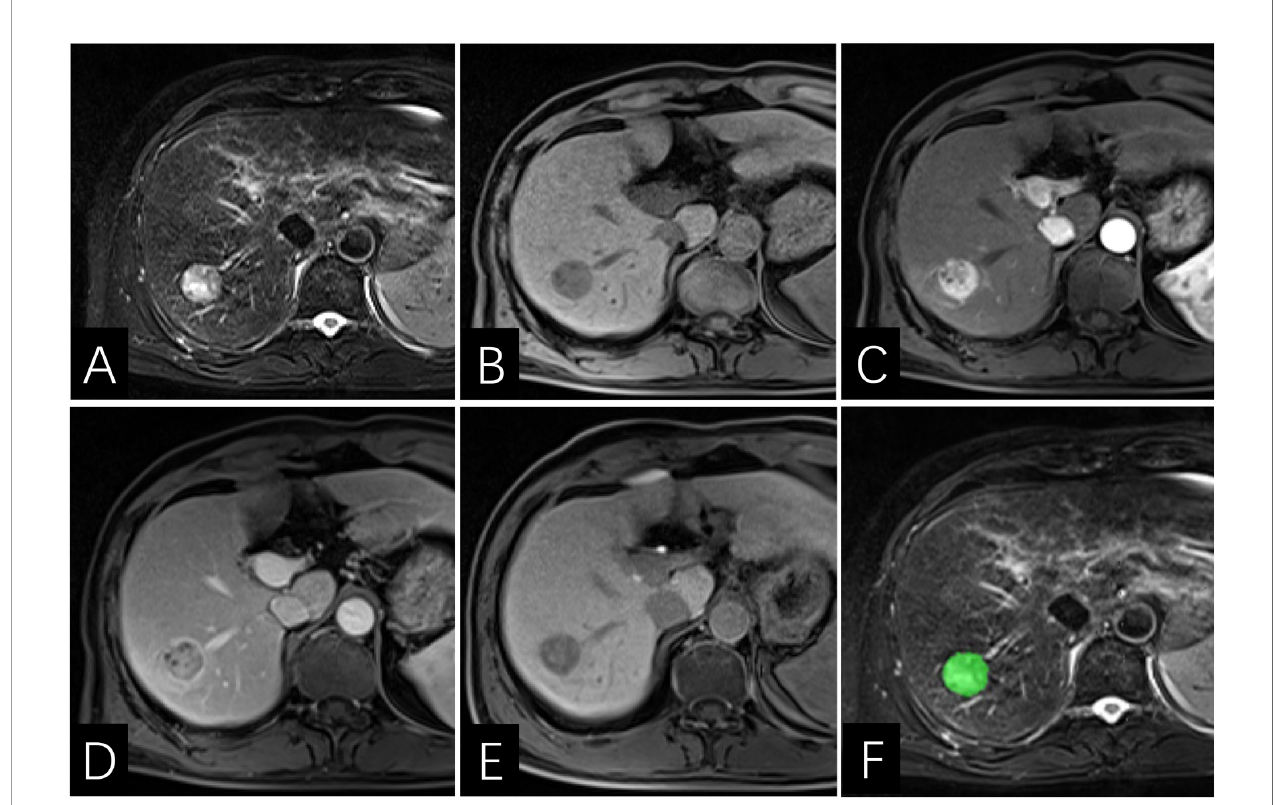
FIGURE 6 | Images of a 64-year-old man with HCC with early recurrence. (A – E) the tumor displays enhancing capsule and hepatobiliary phase hypointensity. (F) the lesion was fi rst ROI segmented in green and the ROI was plotted on each cross section of the entire lesion to get the texture information. The Rad-score of this patient was -5.2, and his PLT is 144×10 3 /ml. Based on the Nomogram, the patient ’ s total score was about 67, indicating that the risk of ER was between